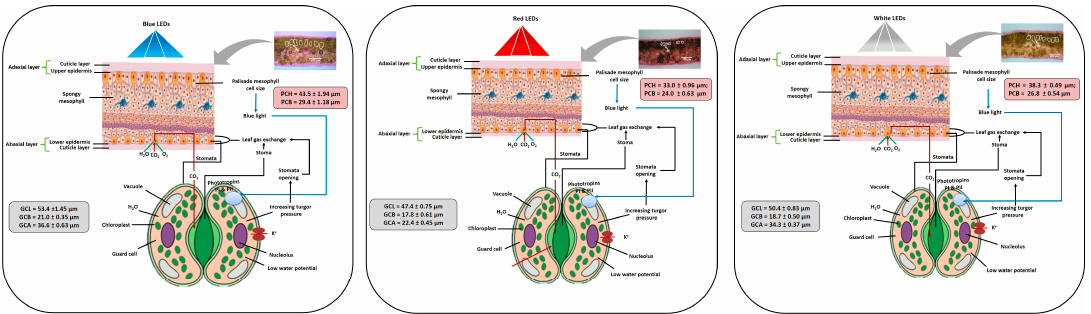
Figure 6. Hypothetical representation of leaf gas exchange, photosynthetic performance, epidermal layer thickness, palisade cell, and stomatal opening traits under blue, red and white LED light. PCH = palisade cell height, PCB = palisade cell breadth, GCL = guard cell length, GCB = guard cell breadth and GCA = guard cell area. Palisade cell image bar = 100 µm.